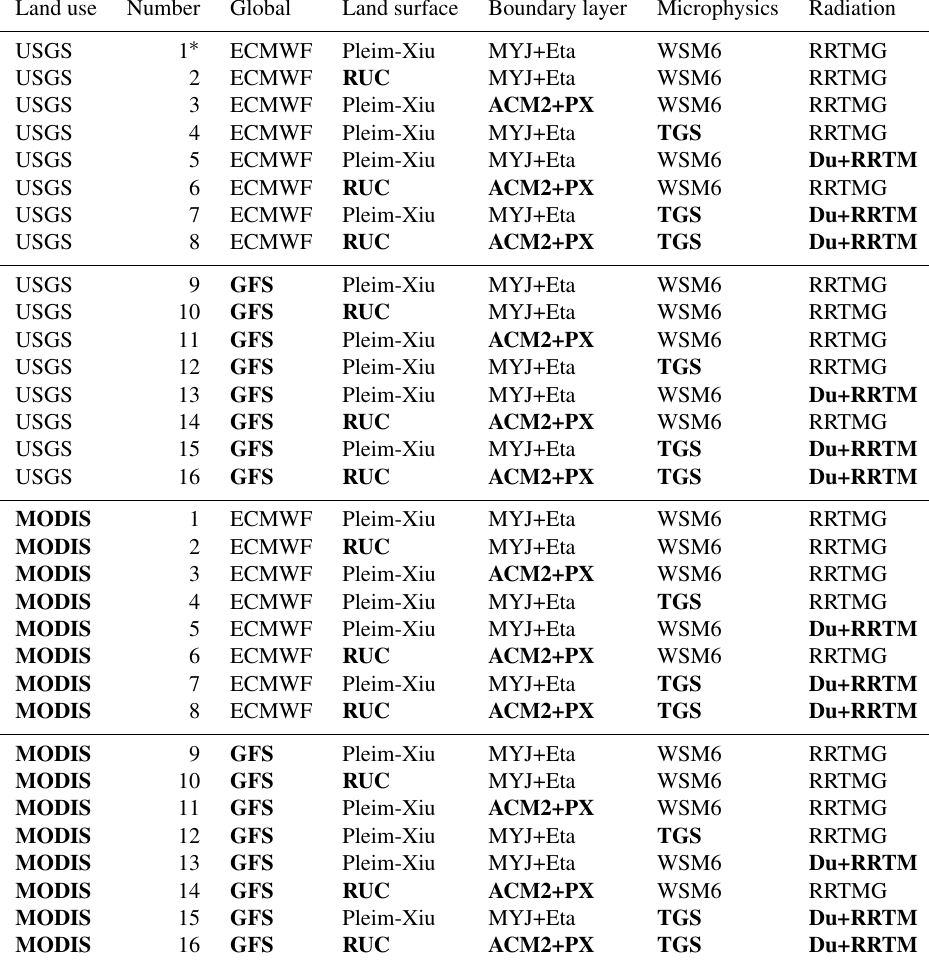
Table B1. Overview of model setups used as combined sensitivities. A detailed description of the abbreviations and model implementations has been provided by Vogel and Elbern (2021a). The reference setup is denoted as ∗ , and deviations from this reference are written in bold letters (PX is the Pleim–Xiu surface layer parameterization; Du is the Dudhia shortwave radiation